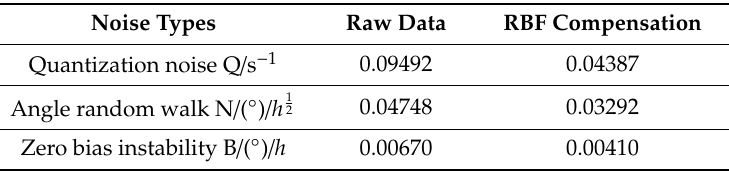
Table 3. X-axis values of the parameters Allan